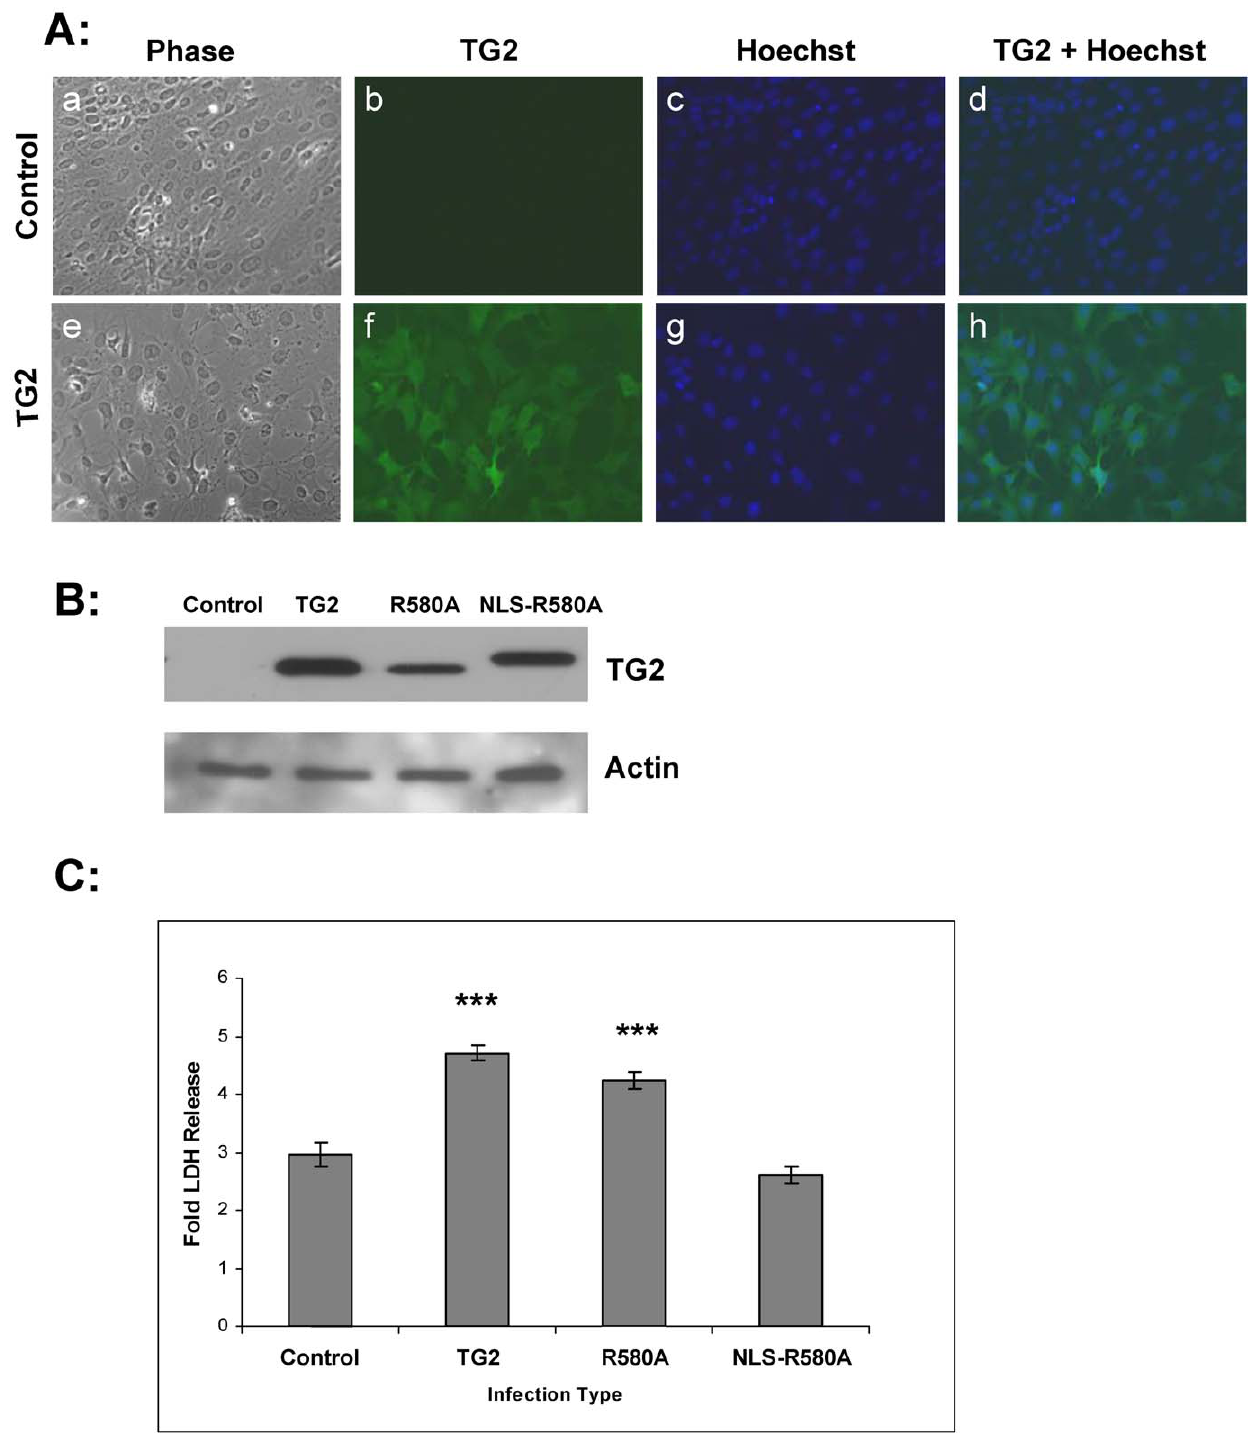
Figure 6. OGD-induced cell death with NLS tagged R580A. A , Immunocytochemistry of naı¨ve striatal neurons that were infected with a control or wild type TG2 lentiviral construct. Panels a, b, c, and d represent the naı¨ve cell transduced with control lentivirus. Panels e, f, g, and h represent naı¨ve cells transduced with wild type TG2. Immunocytochemistry was performed with a TG2 antibody that was recognized by a FITC- conjugated mouse secondary antibody. From left to right: phase, TG2 staining labeled by FITC, Hoechst nuclear staining, merge of FITC and Hoechst staining. B , Immunoblots of cell lysates from naı¨ve cells transduced with control, TG2, TG2-R580A (R580A) and NLS tagged R580A (NLS-R580A) lentiviruses. Actin blot is shown for loading controls. C , Fold LDH release in lentivirus infected striatal cells after 36 hr of OGD at 0.1% O 2 . Both TG2 and TG2-R580A (R580A) expressing cells showed significant increases in fold LDH release after OGD treatment, while NLS-R580A showed similar fold LDH release amount as the control. (N=8) Results are shown as mean + / 2 SEM, ***p , 0.001.